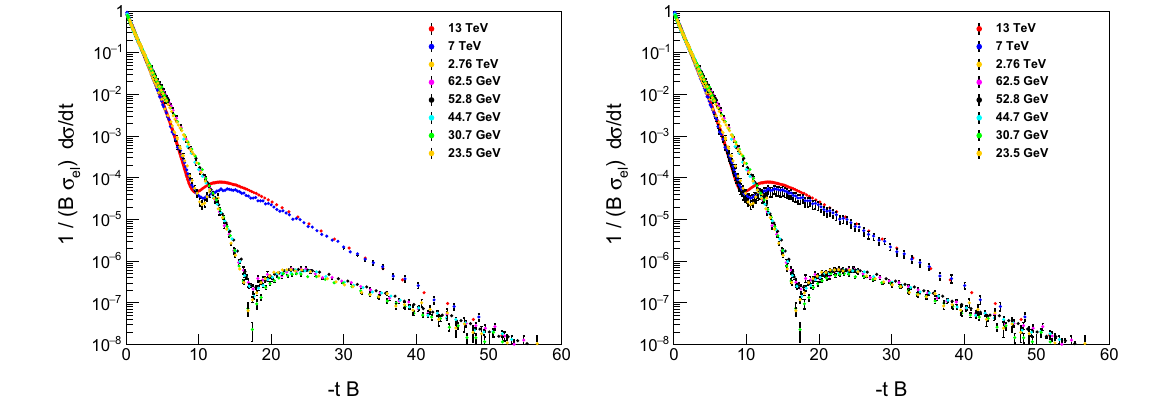
Fig. 3 Scalingbehaviourofthedifferentialcrosssection d σ/ dt ofelas- tic pp collisions from ISR to LHC energies. Data points are the same as shown in Figs. 1 and 2. (Left panel): Data points are shown with